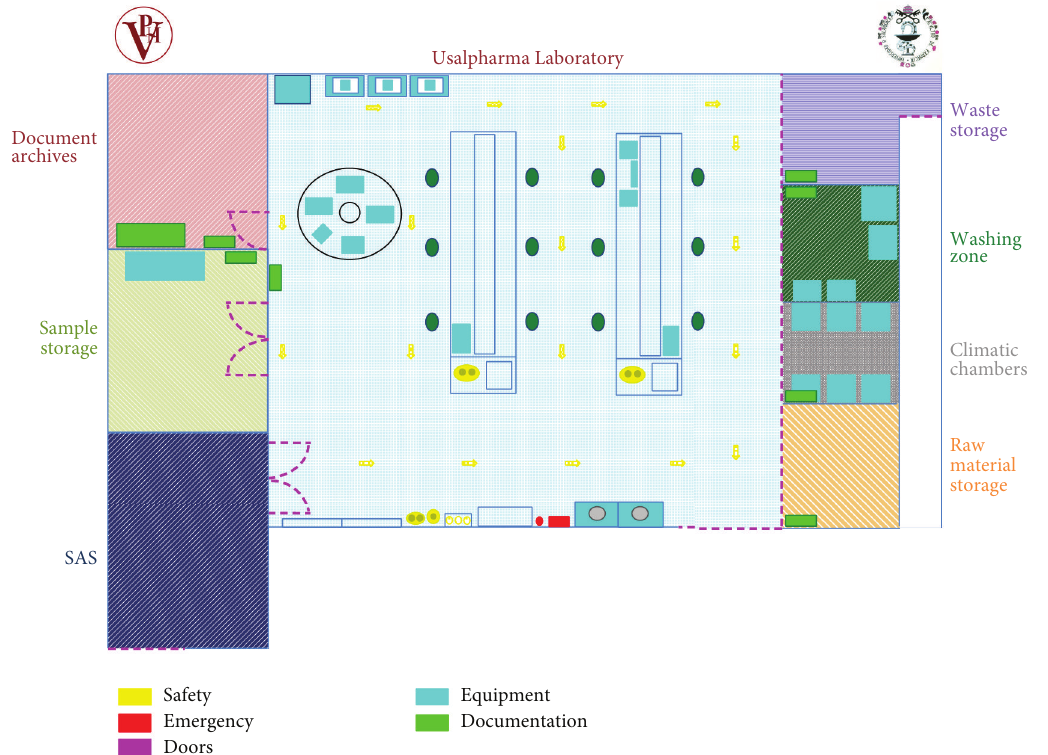
Figure 3: Usalpharma Lab layout.